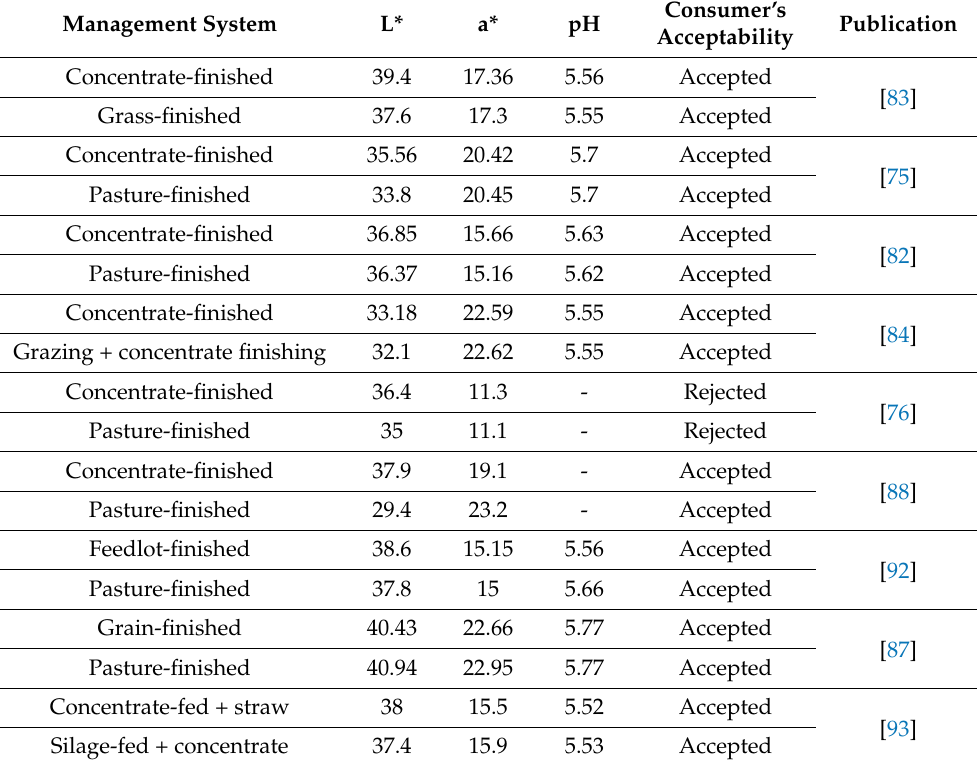
Table 2. Consumer’s acceptability related to meat color and pH differentiation between color-stable and color-unstable muscles in fresh